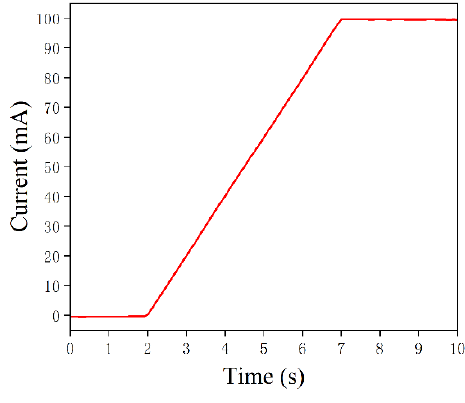
Figure 6. Test results of the slow-start